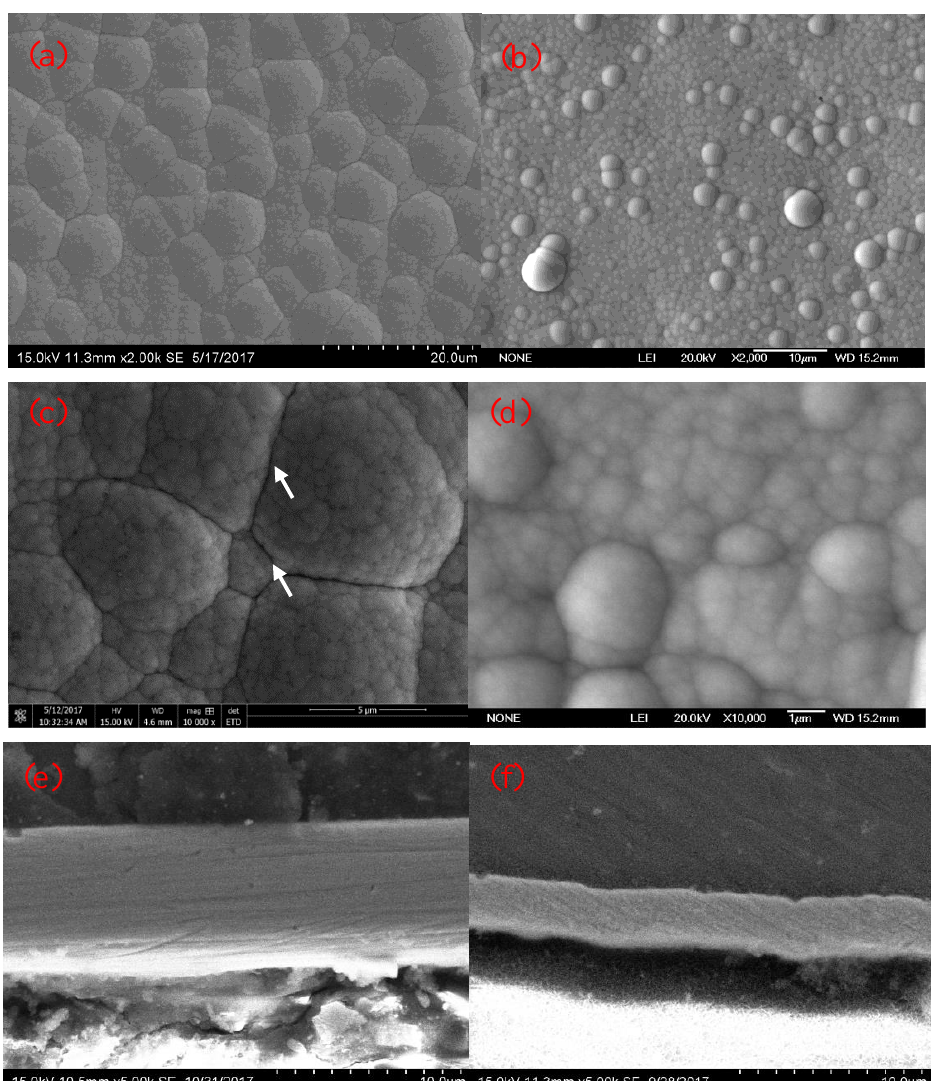
Figure 3. Representative SEM images showing the in-plane ( a , c ), and cross-sectional ( e ) morphology of the Ni-P coating with no interfacial layer (NPC); the in-plane ( b , d ), cross-sectional ( f ) morphology of the Ni-P coating with interfacial phosphate layer (NPC/Phosphate). Note that ( a , b ) are in low magnification, while ( c , d ) are in high magnification.